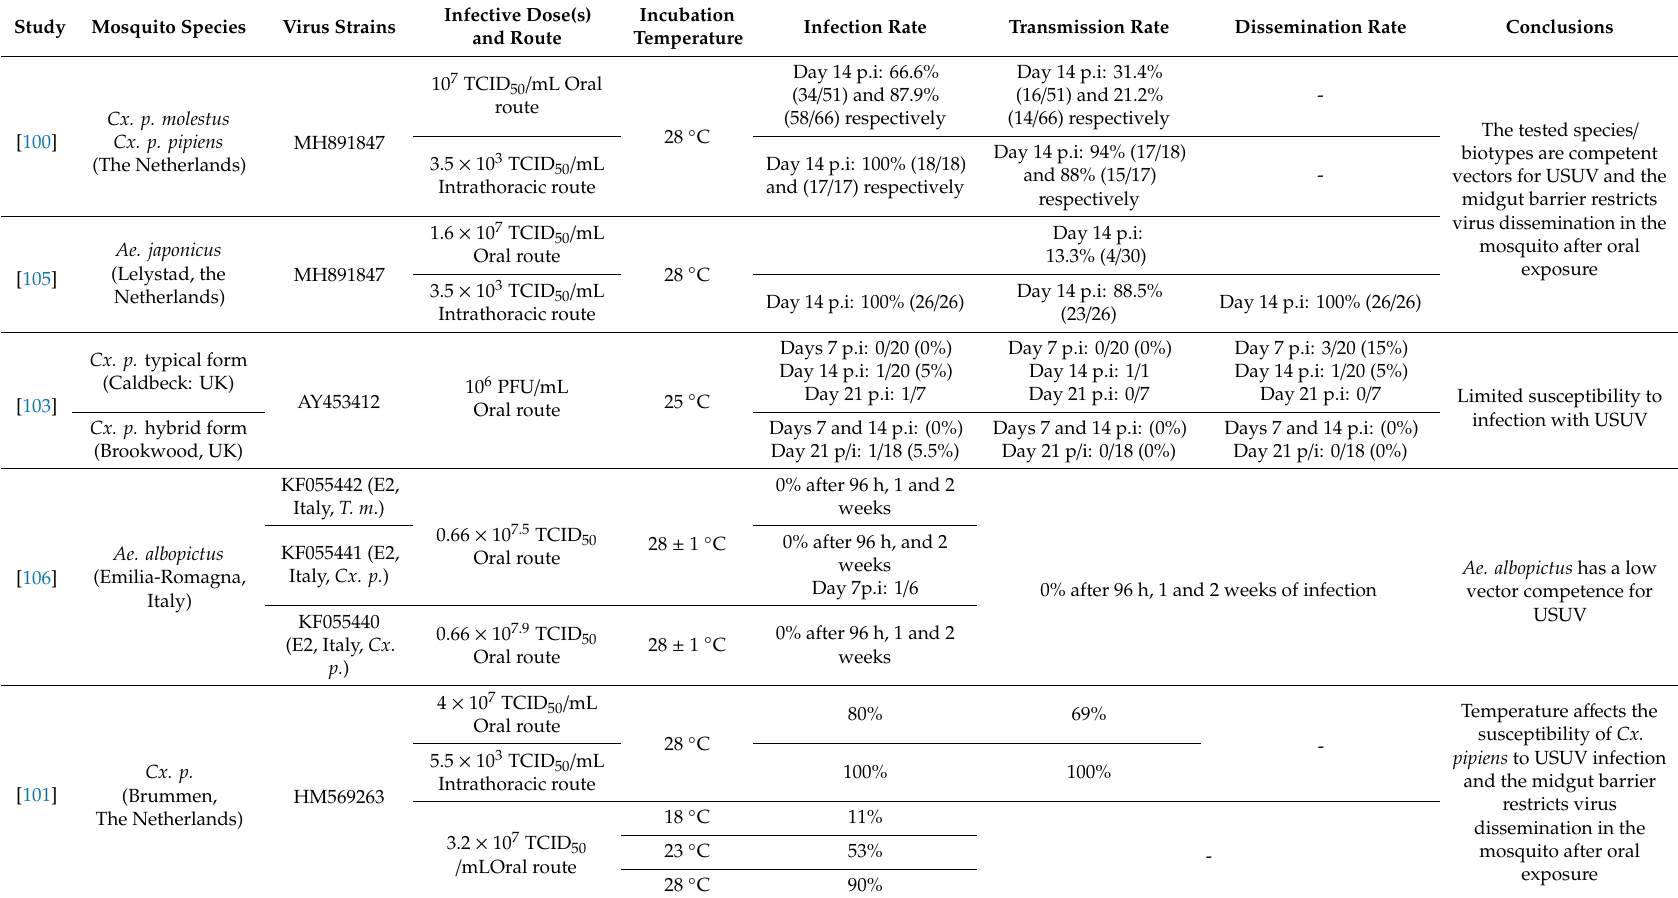
Table 3. Infection studies with USUV in European mosquito